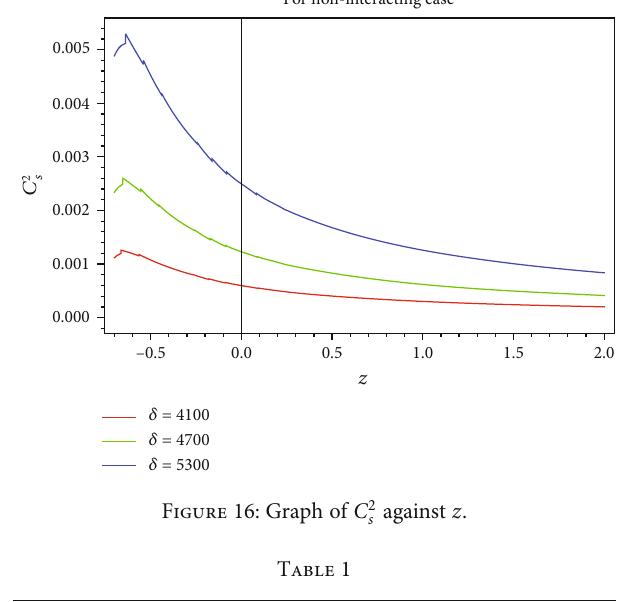
Figure 16: Graph of C 2